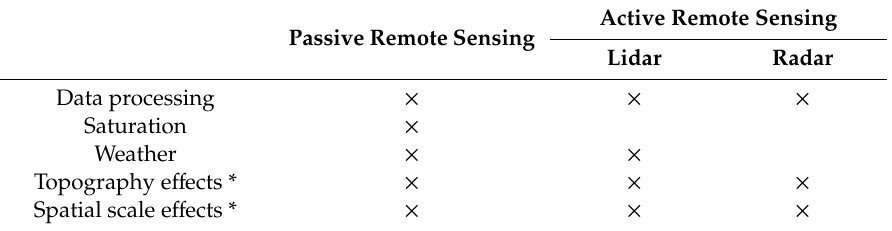
Table 6. Uncertainty sources for di ff erent detection